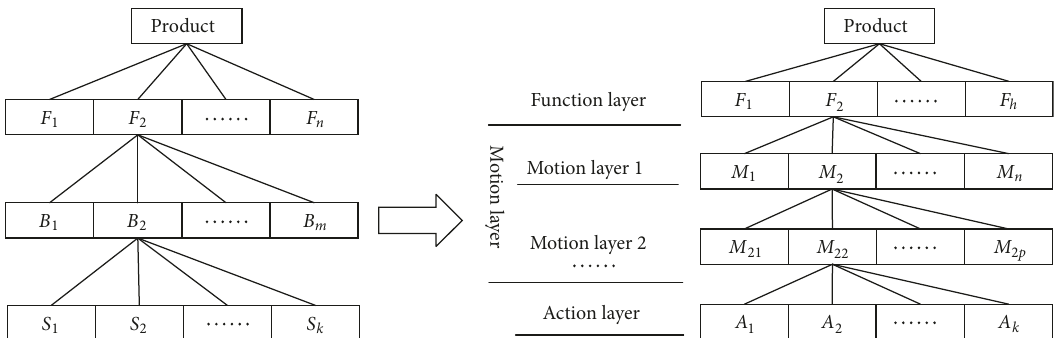
Figure 1: Converting FBS to FMA structural decomposition.